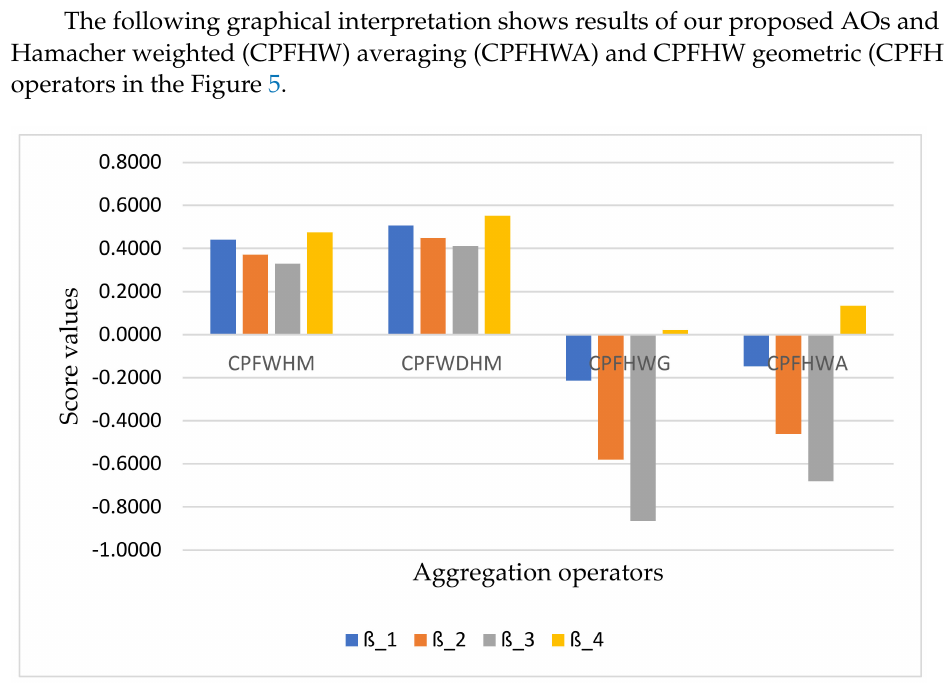
Figure 5. Comparison of existing AOs with our proposed